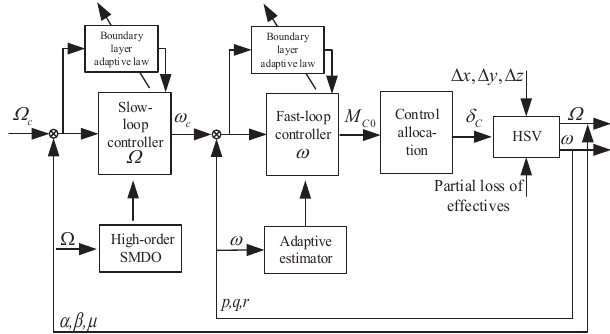
Figure 2. Frame of fault-tolerant controller for HSV with centroid